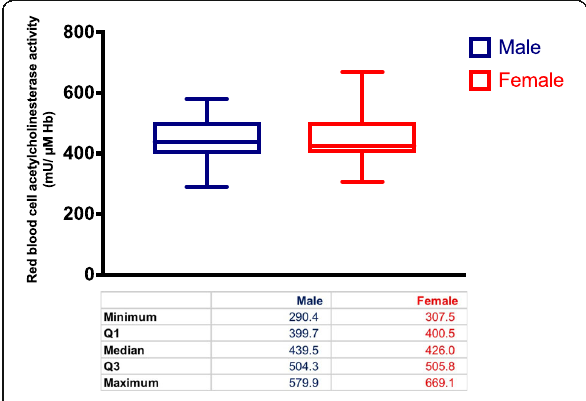
Fig. 2 Red blood cell acetylcholinesterase activity by sex, among healthy non-farmers of Anuradhapura,